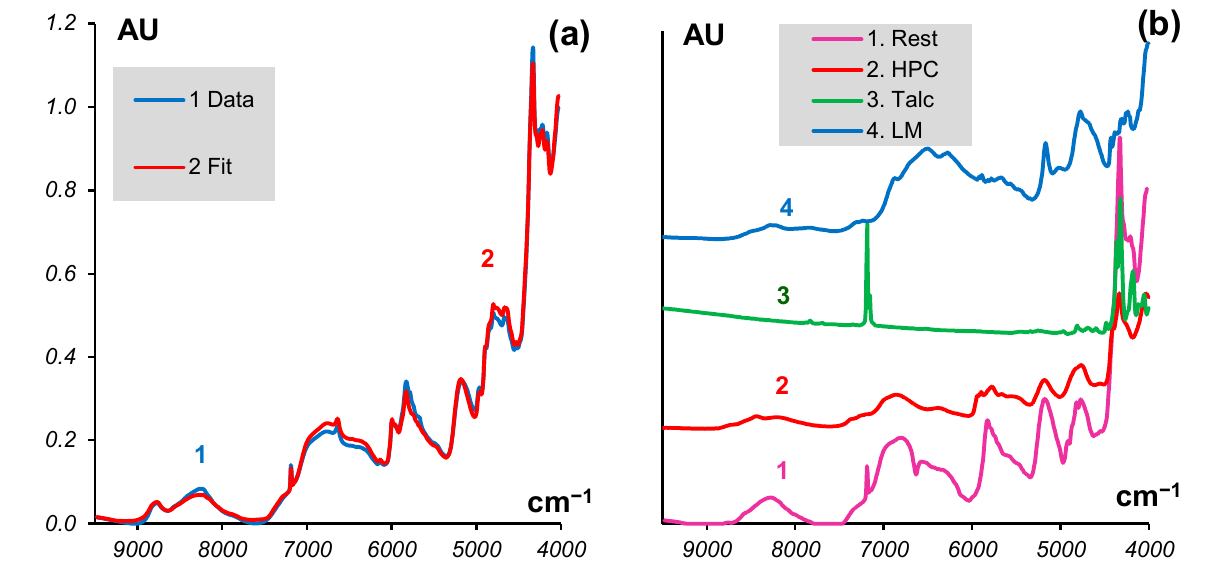
Figure 4. ( a ) Experimental spectrum (1) and its fit by MCR (2); ( b ) Spectrum of Rest and the spectra of some common excipients (vertically shifted).